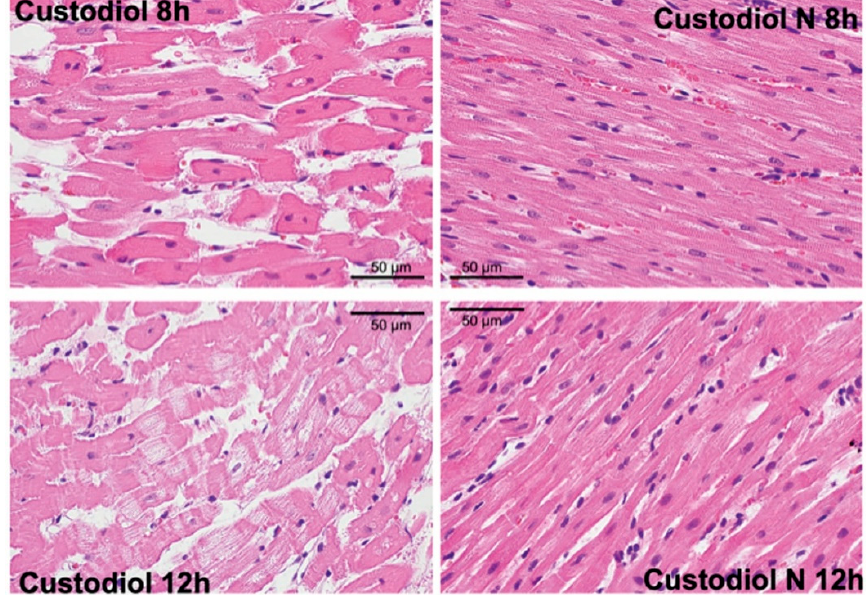
Figure 6. Histology. Representative histopathological sections (haematoxylin–eosin staining) of the left ventricular myocardium of transplanted hearts in each experimental group. left ventricular myocardium of transplanted hearts in each experimental